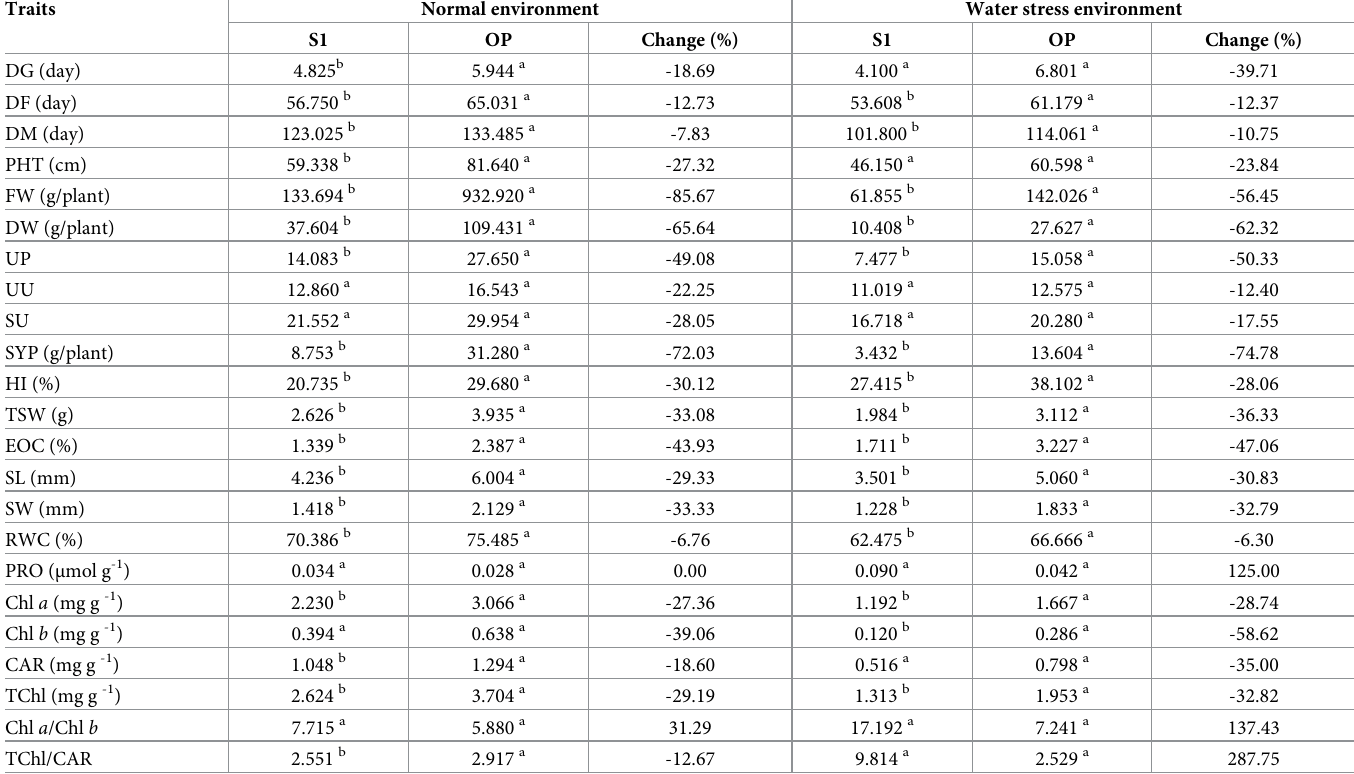
Table 3. Effect of selfing on different traits of fennel under normal and water deficit conditions during two years (2019–2020).